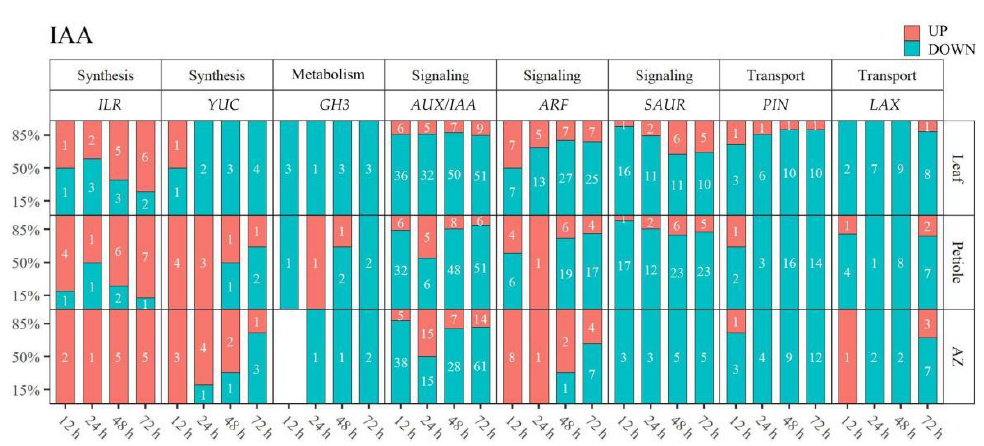
Figure 8. TDZ regulates the gene expression of IAA metabolism, transport, and signal. DEGs were determined between 12 h and 0 h, 24 h and 0 h, 48 h and 0 h, 72 h and 0 h, respectively. The DEGs were controlled by FDR < 5% and |log2Fc| ≥ 1. White digits indicate the gene numbers.